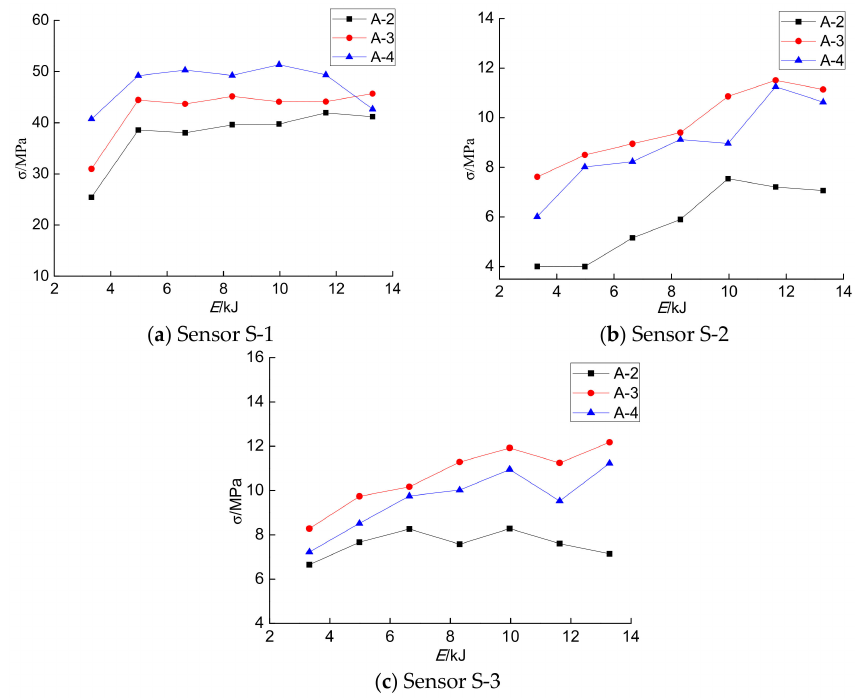
Figure 11. The concrete internal stresses with different wall thicknesses.